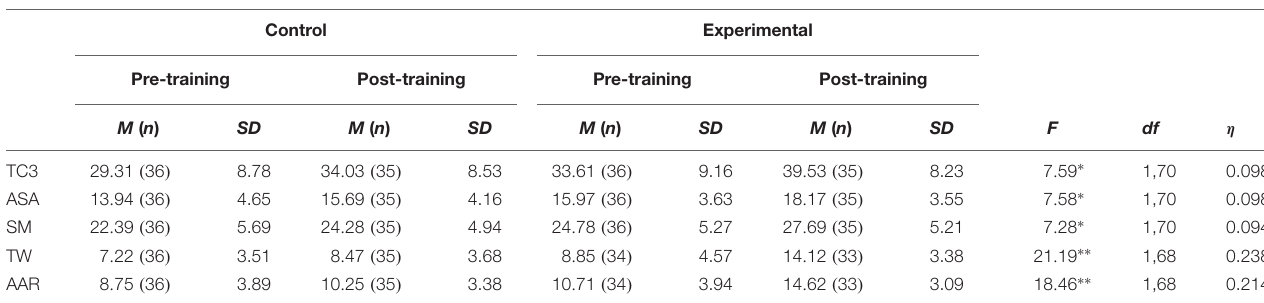
TABLE 1 | Overall main effect of condition on self-reported skills following training.